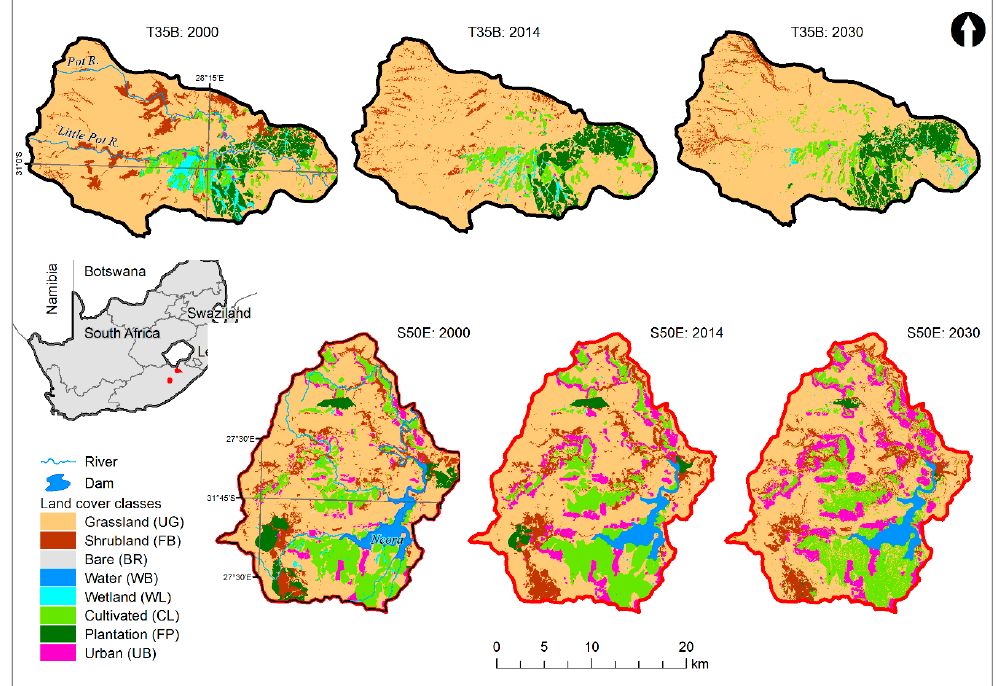
Figure 1. Study area with land cover classification for 2000, 2014 and 2030.